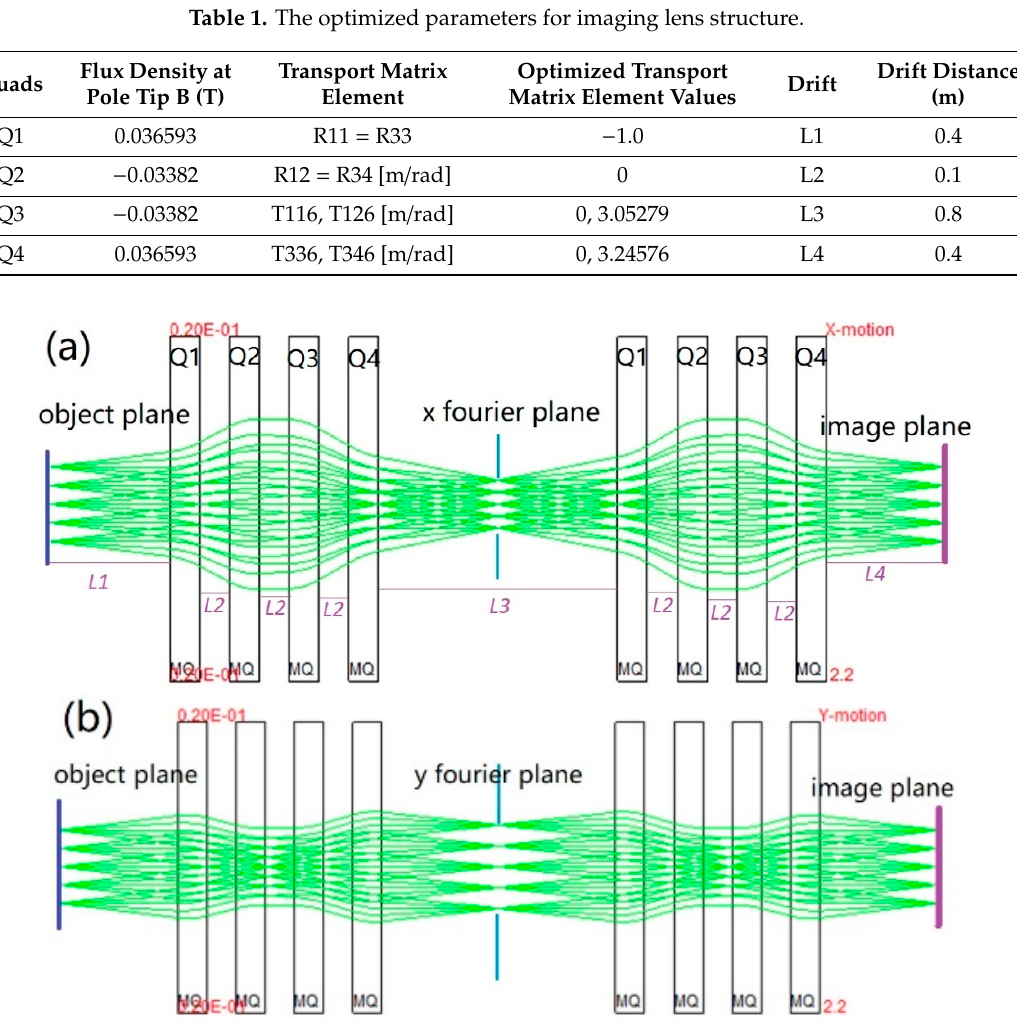
Table 1. The optimized parameters for imaging lens structure.